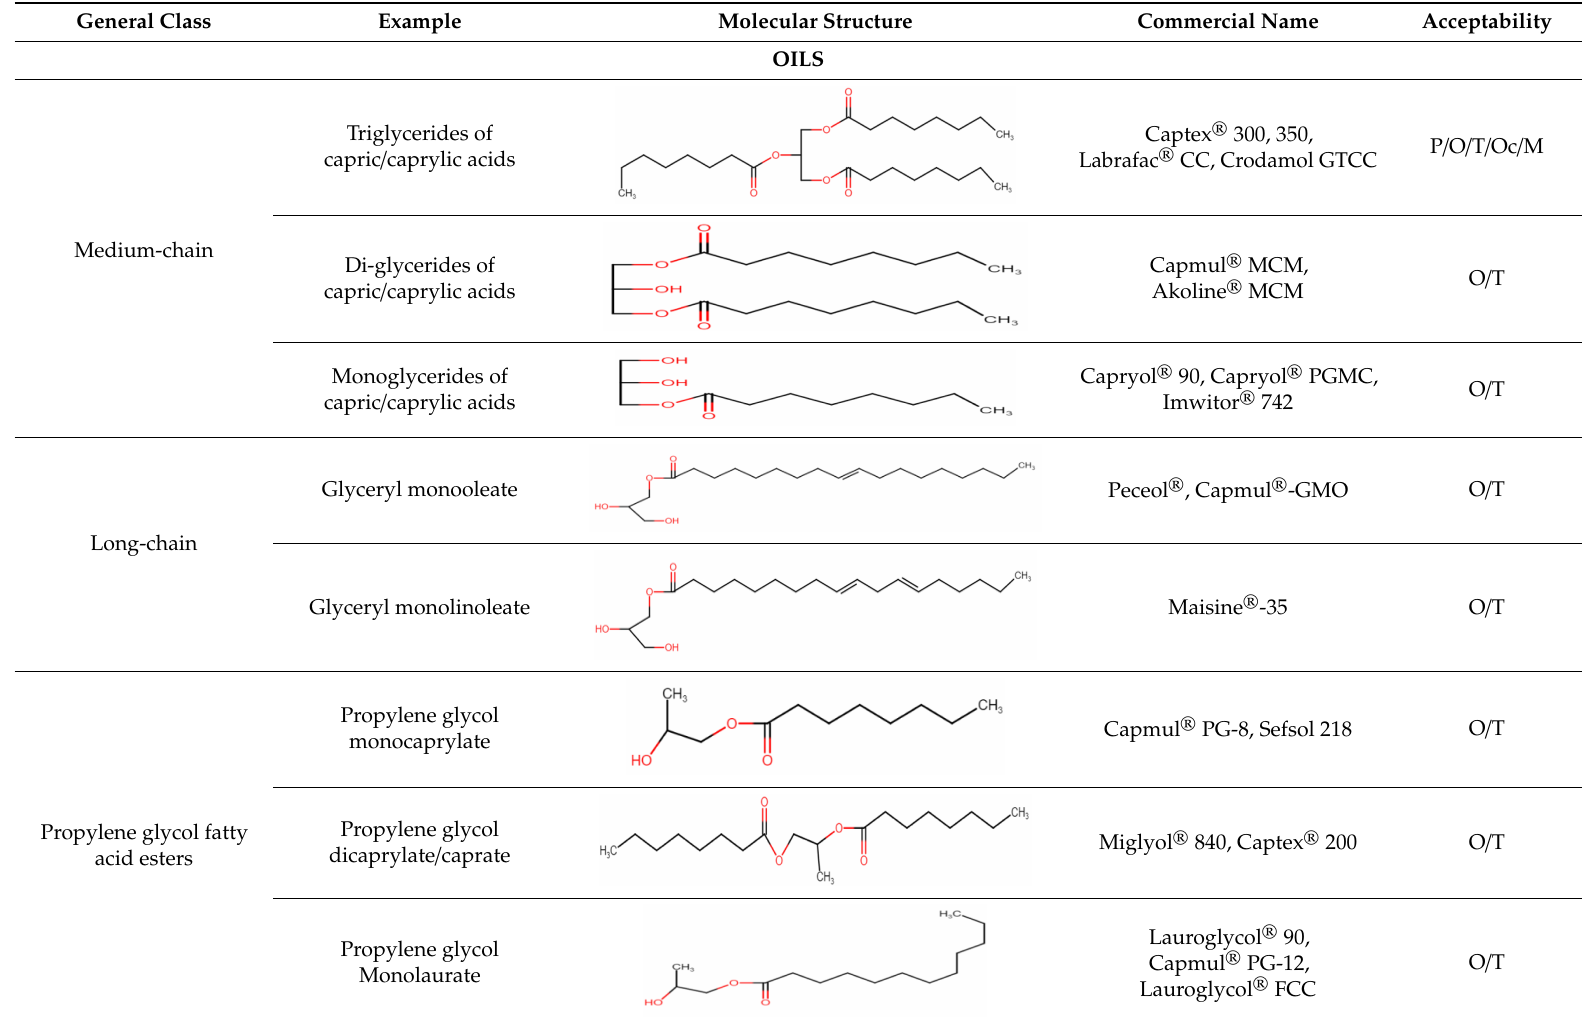
Table 1. Commonly used oils, surfactants, and